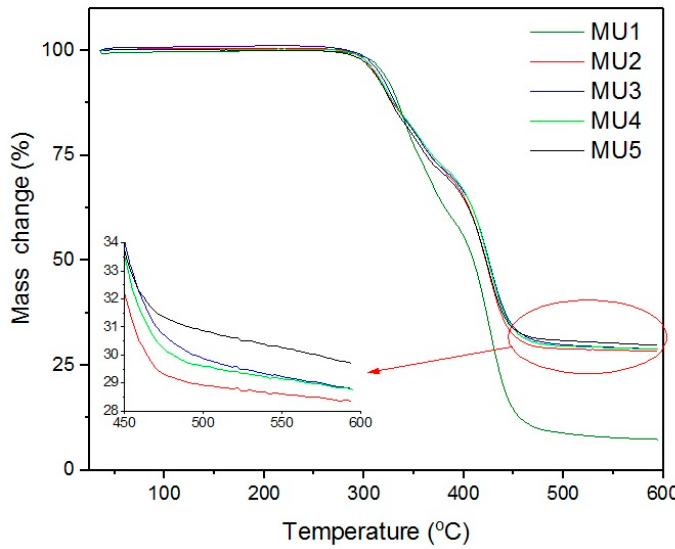
Figure 10. Thermogravimetric curves of all materials.